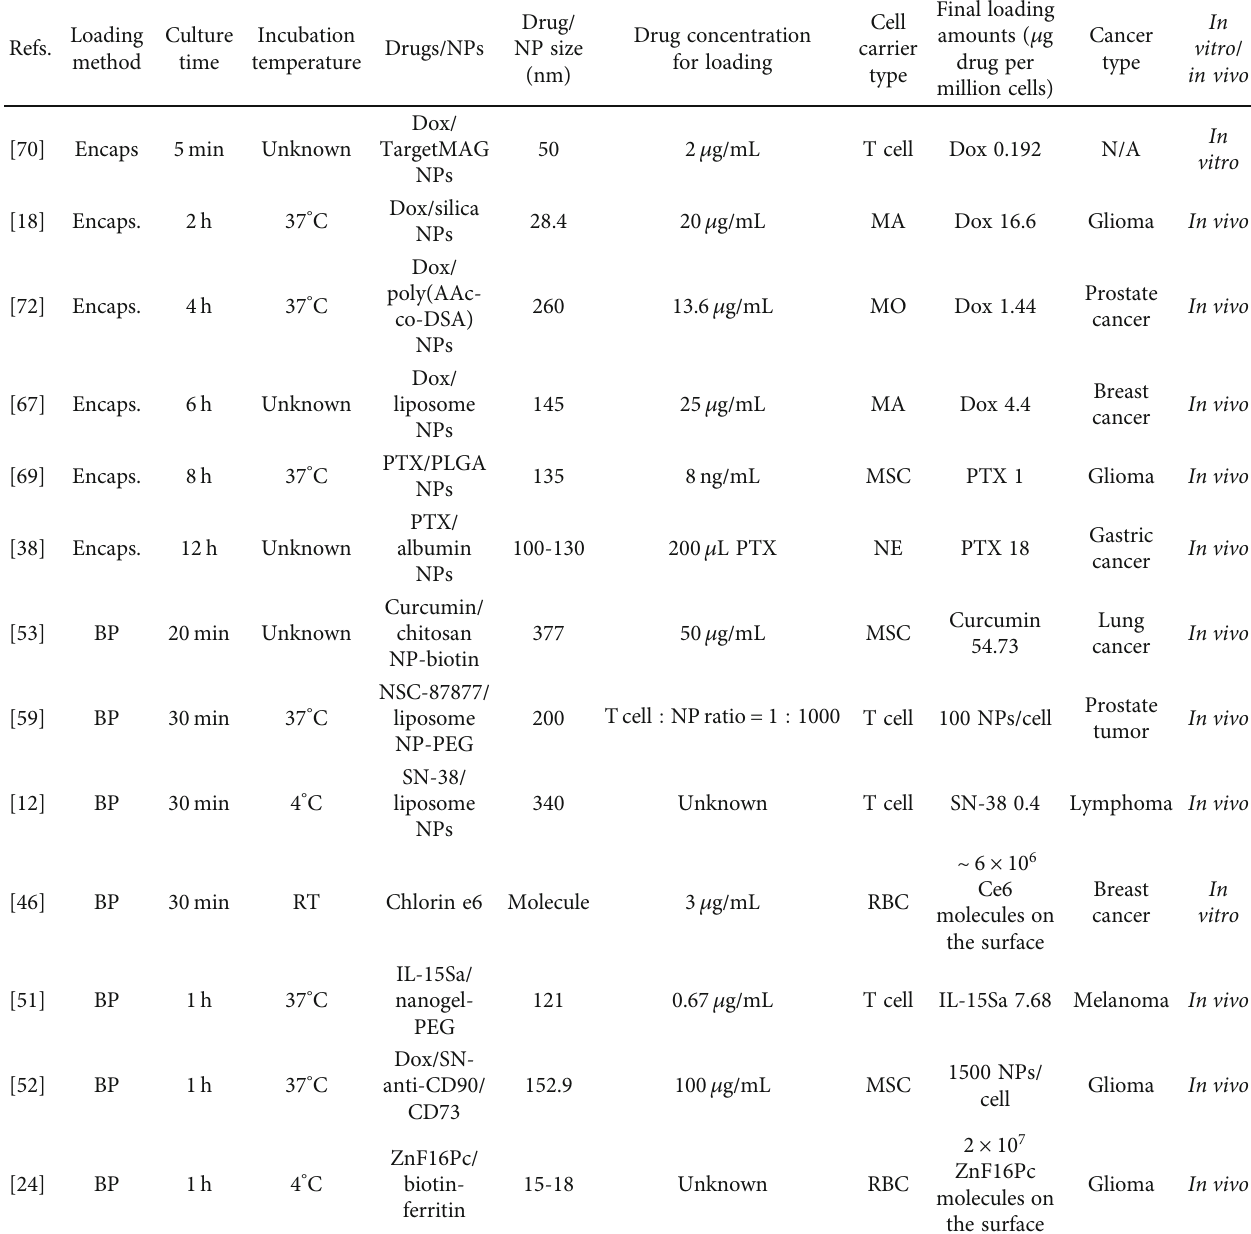
Table 2: Cargo loading conditions of encapsulation and backpack